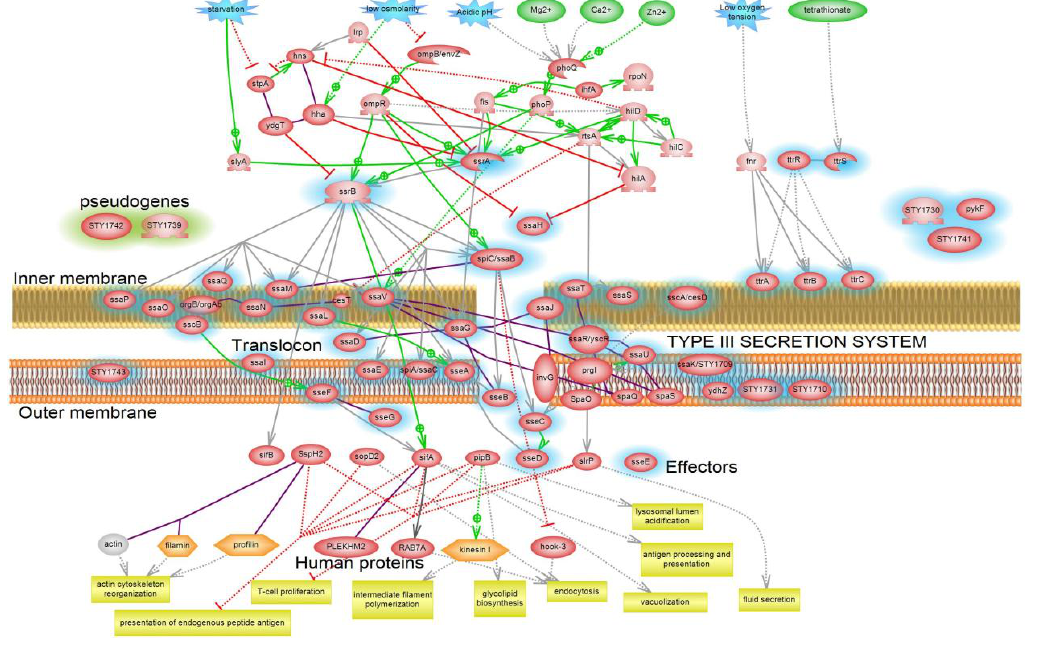
Figure 3: SPI-2 regulation pathway. SPI-2 encodes for T3SS and the expression of genes is governed by OmpB-OmpR and SsrA-SsrB. Proteins encoded by SPI-2 are highlighted in